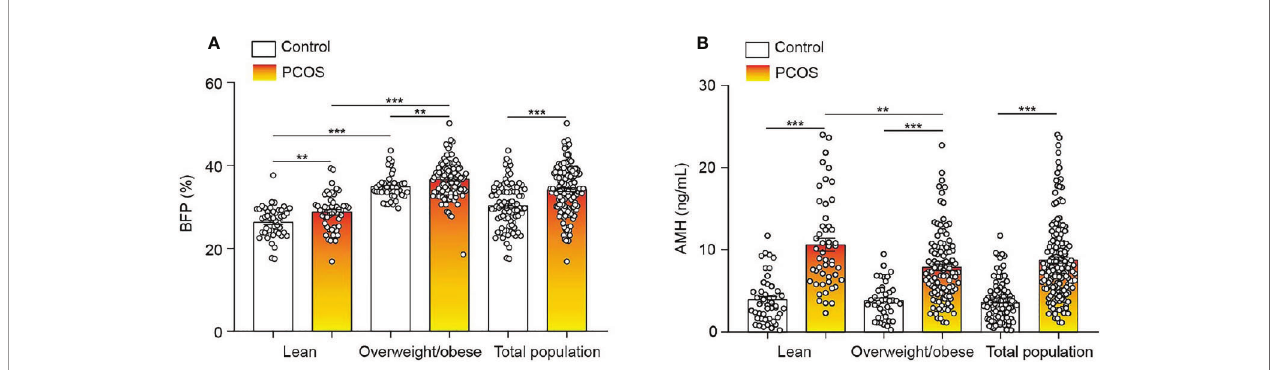
FIGURE 1 | BFP and serum AMH levels of the control and PCOS groups. (A) Differences in BFP between lean and overweight/obese control and PCOS groups. (B) Differences in AMH levels between lean and overweight/obese control and PCOS groups. Bar graphs show the standard error of mean. ***P < 0.001, **P < 0.01. PCOS, polycystic ovary syndrome; BFP, body fat percentage; AMH, anti-Müllerian